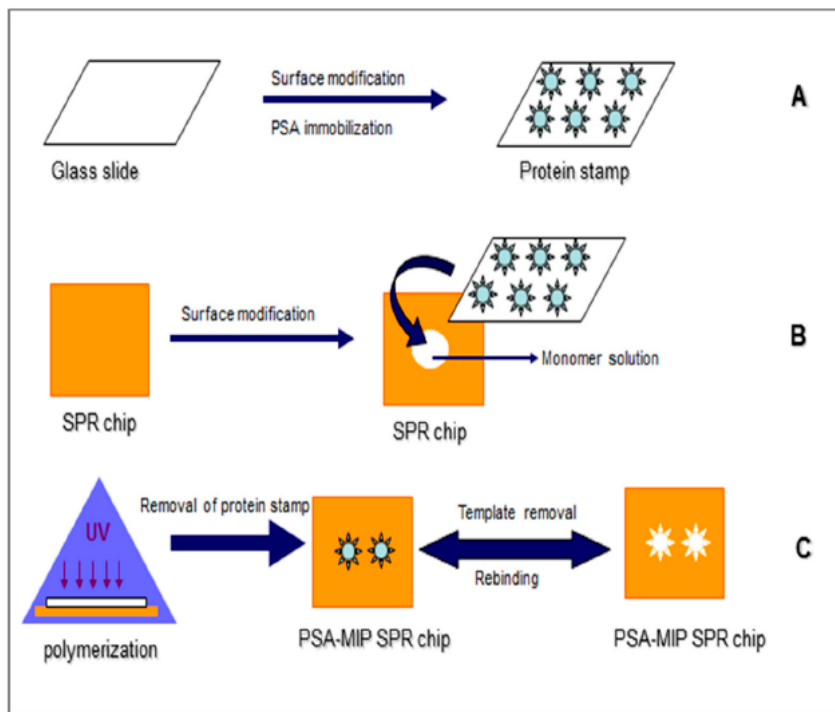
Figure 3. Schematic representation of microcontact imprinting of PSA onto the SPR biosensor surface: ( A ) Preparation of glass cover slips (protein stamps); ( B ) preparation of SPR chips; ( C ) microcontact imprinting of PSA onto the SPR biosensor chip surface via UV-polymerization (reproduced from [52] with permission).